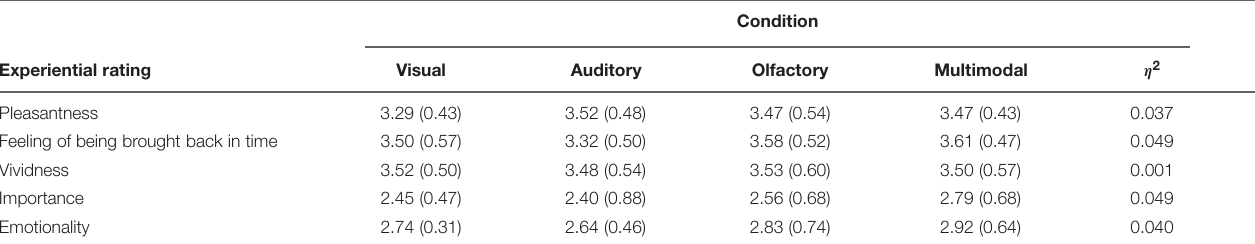
TABLE 3 | Mean experiential ratings (and SD) across the four conditions and η 2 for the five